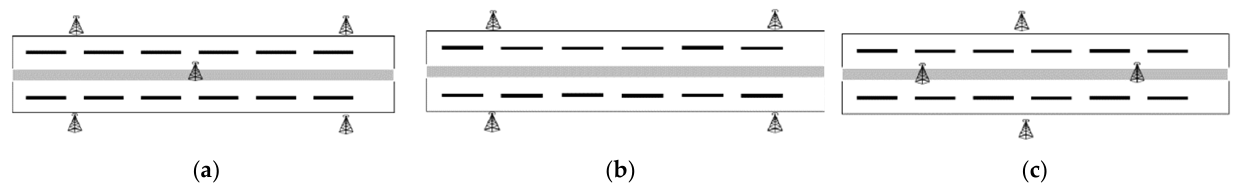
Figure 2. The topologies of ITB: ( a ) X-type; ( b ) rectangle-type; ( c ) diamond-type.